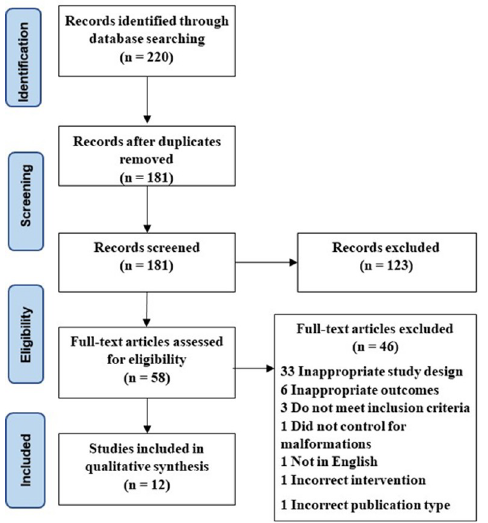
Fig 1. Preferred reporting items for systematic reviews and meta-analyses (PRISMA) flowchart detailing study design.